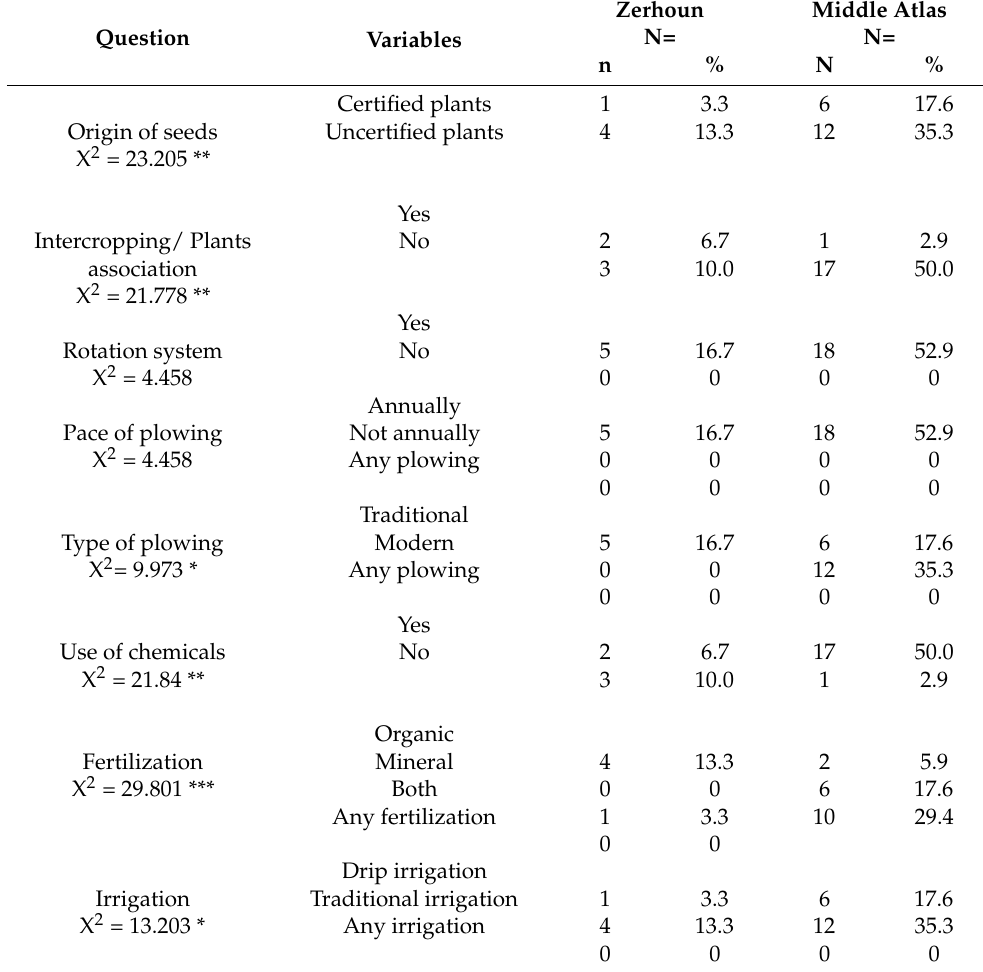
Table 3. Agricultural practices-Vegetable crops (* denote significant difference, * equivalent to p < 0.05, ** equivalent to p < 0.001, and *** equivalent to p <